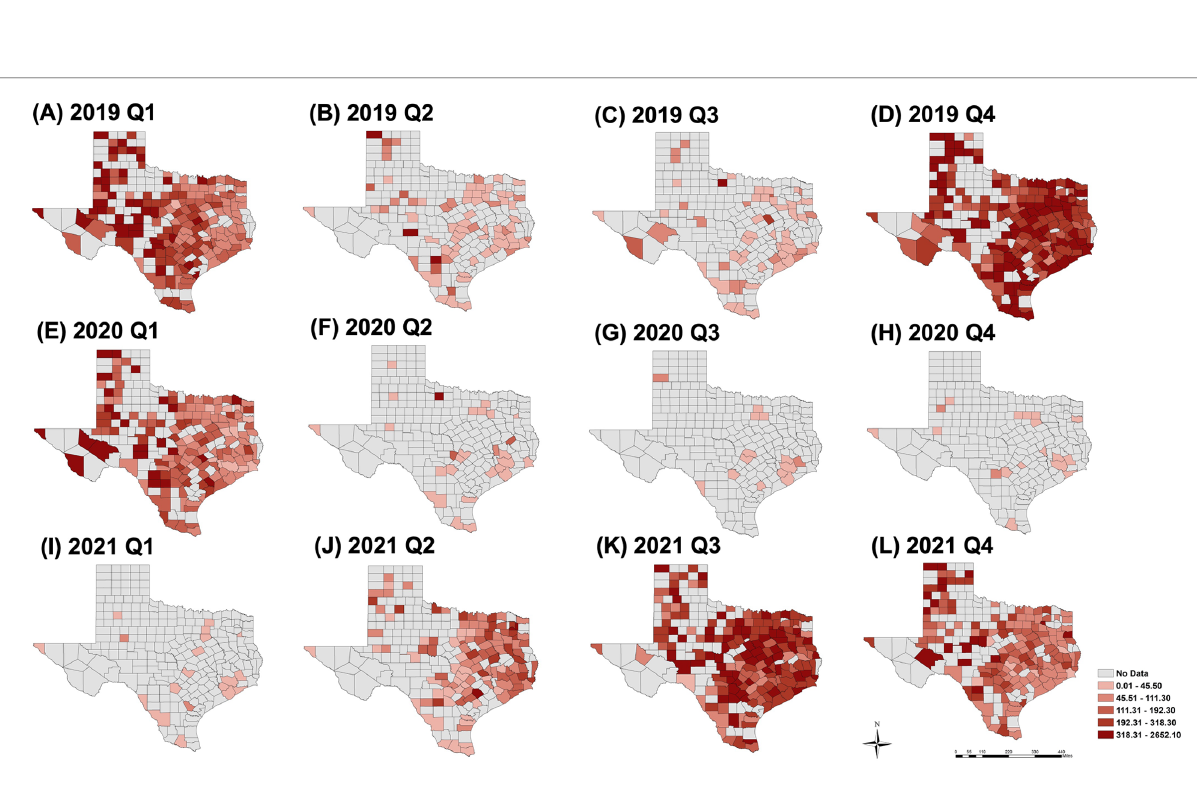
RSV re-emergence appears to follow a typical onset (2019 Q2) but with higher and more broadly distributed rates throughout the east of the state. In the rural area of the southwest border (without